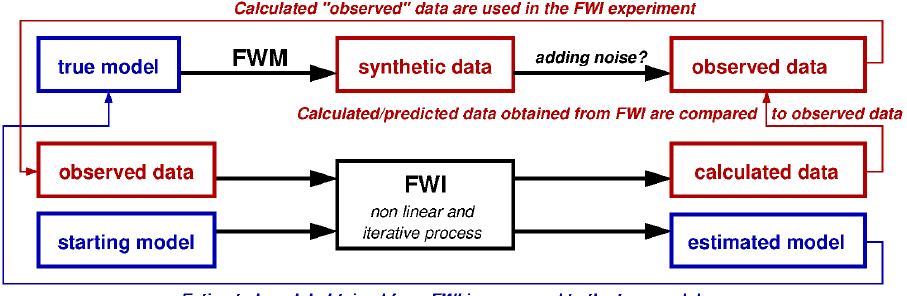
Figure 1. Workflow of the method used in the feasibility study. (1) From the true model (including the fault), we generate the synthetic data by FWM. (2) Add or not the noise according to the objective of the experiment. This data is then used in the inversion as observed data. (3) Start the inversion process from the starting model (which is the true model without the fault) and the observed data, and (4) once the nonlinear iterative FWI process has converged, we obtain (i) the estimated data that will be directly compared to the observed data, and (ii) the estimated models, which are directly compared to the true models. Here, the term “observed data” should not be confused with the term “real data” because we are dealing only with synthetic data.